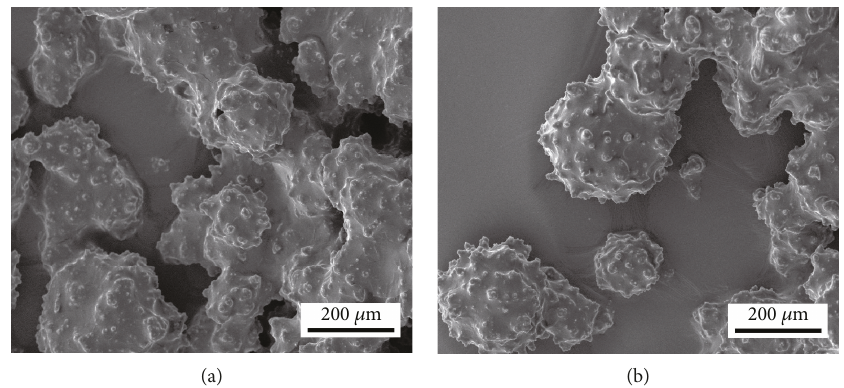
Figure 5: SEM image of the best microcapsule (sample 17).